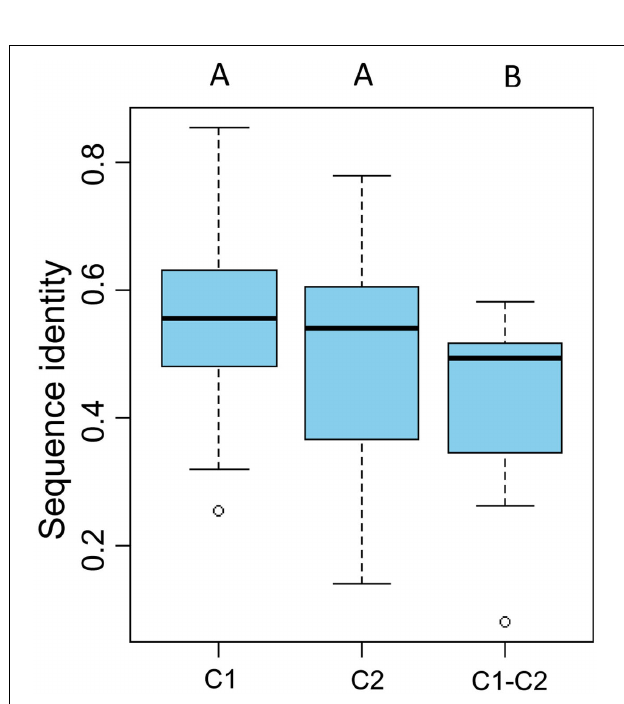
FIGURE 3 | Pairwise sequence identity of full-length LOX proteins. C1 and C2 represent pairwise sequence identities of clade 1 and clade 2 proteins, respectively. C1–C2 represent pairwise sequence identities between the C1 and C2 clades. The boxplot shows the median (black line), interquartile range (box), and maximum and minimum values (whiskers) for each data set. Circles are outliers. Characters above the figure indicate significant differences between groups at p = 0.01, Mann–Whitney